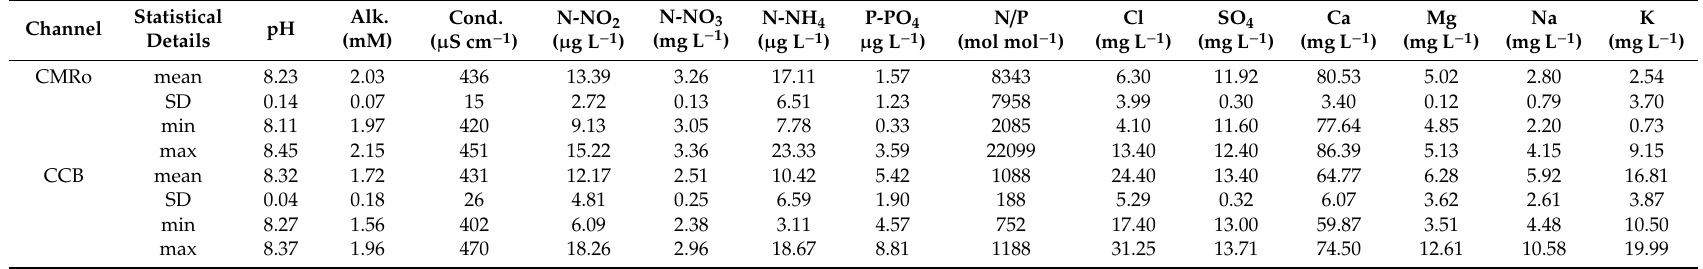
Table 1. Water analyses in sections of two navigation channels in Northeast France, the Canal from Champagne to Bourgogne (CCB) and the Canal from the Marne to the Rhine, Western Branch